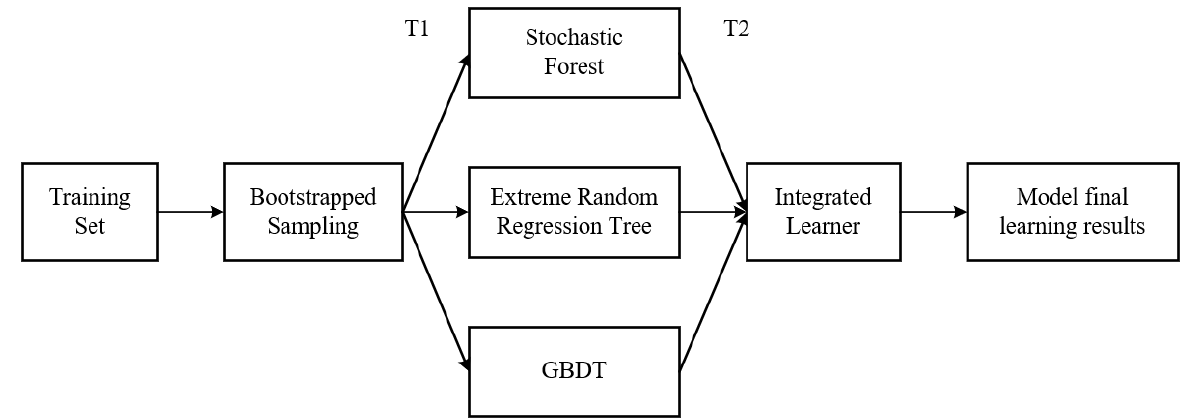
Figure 4. Model construction of stacking